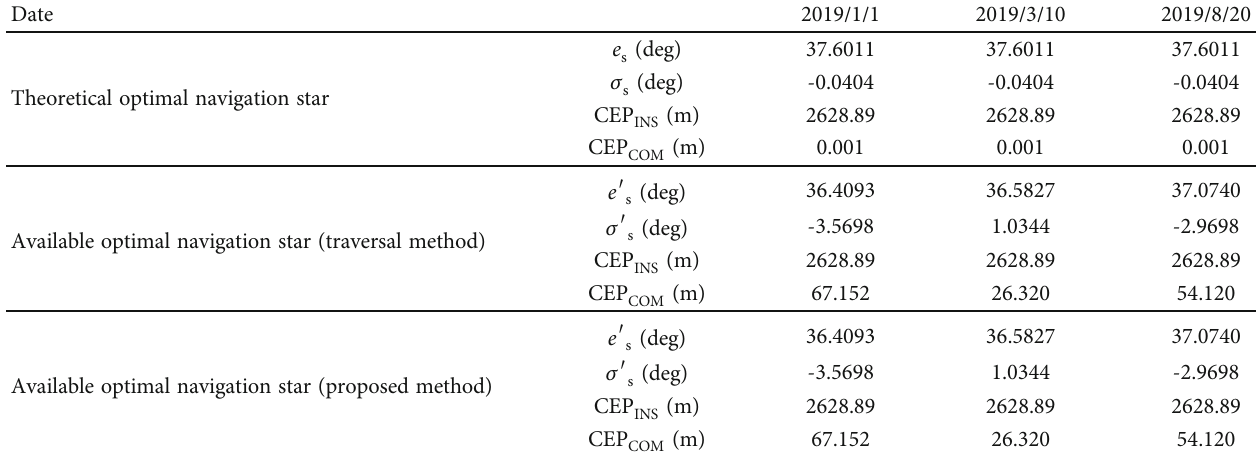
Table 8: The available optimal navigation stars for the 6000 km launch vehicle.